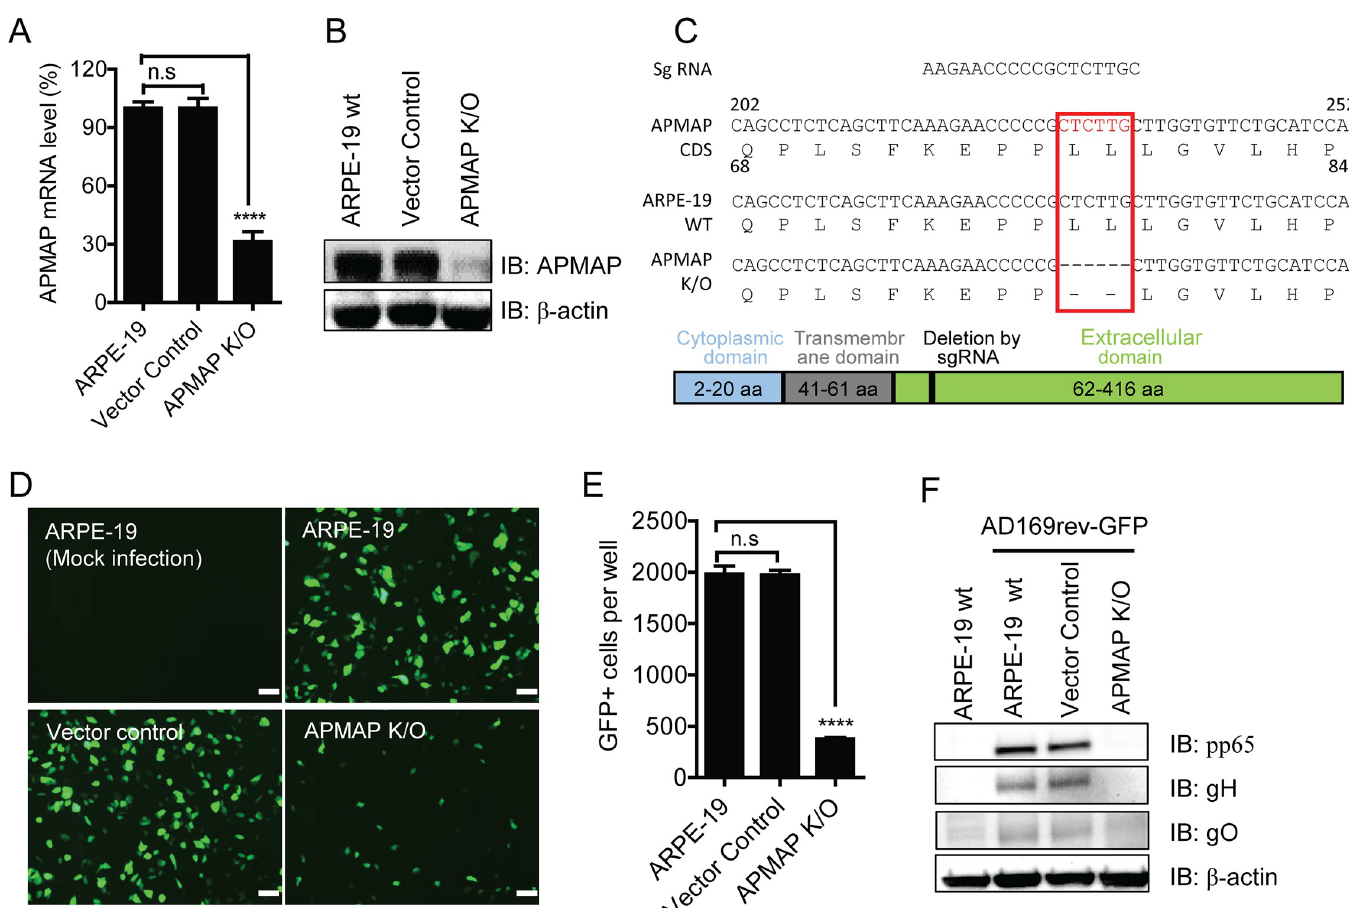
Fig 2. Reduced HCMV infection in APMAP K/O ARPE-19 cells. ( A ) APMAP mRNA level in wildtype ARPE-19, vector control and APMAP K/O cells were quantified by RT-qPCR. GAPDH mRNA served as internal control. The data were shown as relative APMAP mRNA level to that of wildtype ARPE-19 cells. The bars represent means ± SD of replicate wells. ( B ) APMAP knockout in ARPE-19 cells were confirmed by western blot analysis using 4F6 mAb which recognizes APMAP. GAPDH served as loading control. ( C ) Sequencing of APMAP gene of wildtype ARPE-19 and the APMAP K/O cells revealed two amino acids deletion in APMAP genes near the transmembrane domain in the K/O cells. ( D ) Wildtype ARPE-19 and APMAP K/O cells grown in 96-well plate were infected with AD169rev-GFP at MOI = 1.0, and the images were taken at 48 h after infection to detect GFP expression. Bar = 100 μ m. ( E ) Quantitation of GFP positive cells in (D). Total number of GFP positive cells per well were shown. The bars represent means ± SD of GFP positive cells in four replicate wells. ( F ) Detection of HCMV protein expression in (D) by western blot analysis using anti-gH, anti-pp65, and anti-gO antibodies, respectively. β -actin served as loading control. The APMAP mRNA level (%) or number of GFP+ cells in vector control and APMAP K/O cells were compared individually to that of wildtype ARPE-19 cells using unpaired two-tailed student t-test for significance analysis.